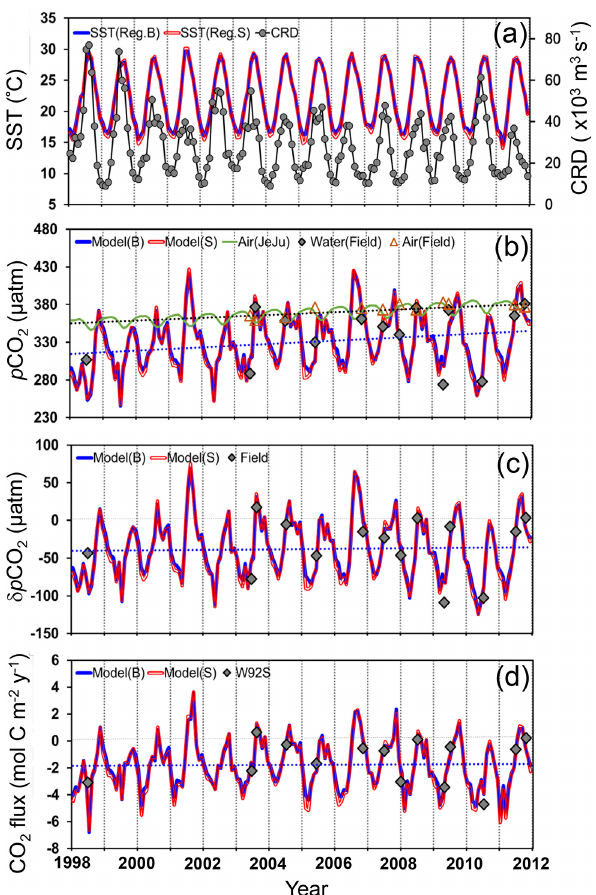
Figure 7. Time-series variations (model results with observed data of 14 cruises) in monthly areal mean (a) SST and CRD, (b) p CO 2w and p CO 2a , (c) δp CO 2 , and (d) CO 2 flux in the sea surface of the ECS shelf (“+”: sea to air; “ − “: air to sea) between 1998 and 2011. The tick on the time axis corresponds to 1 January of the year marked.